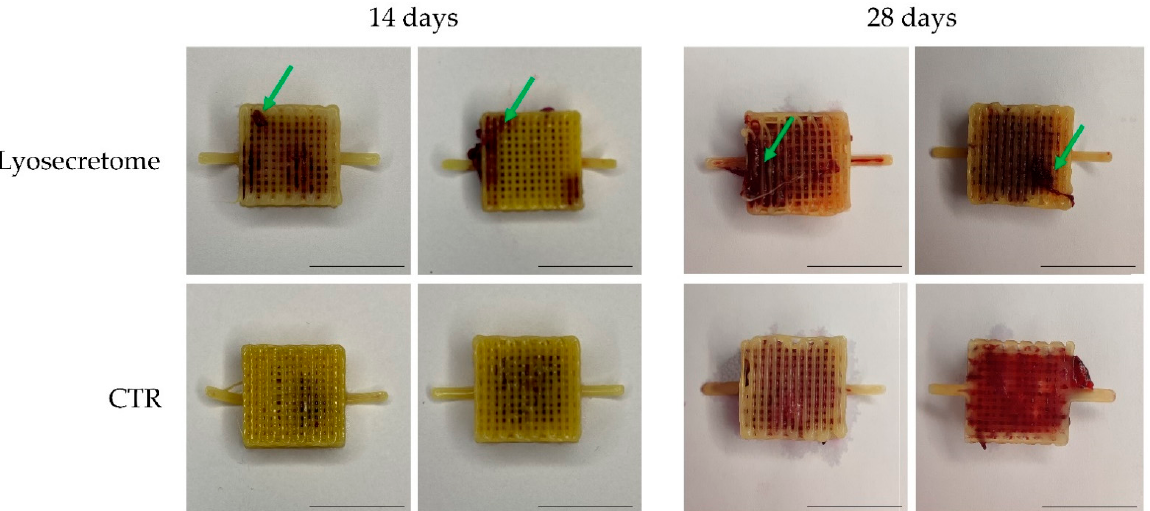
Figure 3. Representative images for the macroscopic evaluation of the mineralized matrix deposition (green arrows) colored by alizarin red on Lyosecretome or CTR scaffolds. Scale bar: 1 cm. Next, the alizarin red bound to the mineralized matrix was dissolved and quantified (Figure 4). According to macroscopic observations, after 14 days, a significantly higher amount of alizarin red was detected in the Lyosecretome scaffolds. At 28 days, no significant differences were revealed between the Lyosecretome and CTR scaffolds.